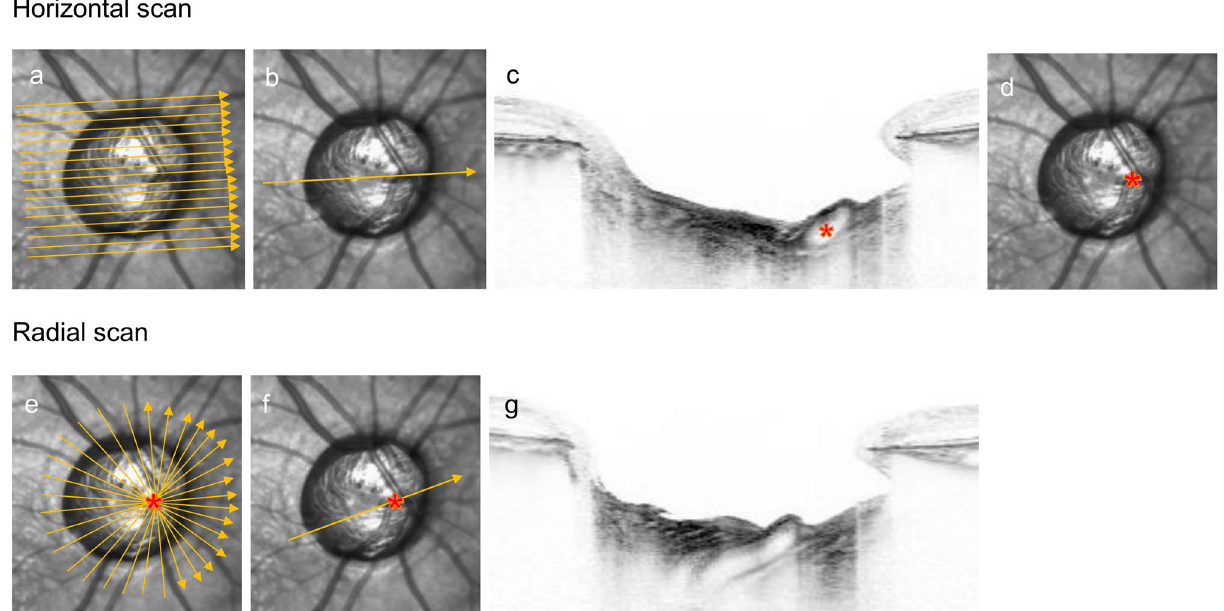
Figure 1. Captured path of the central retinal vessel (CRV) through the lamina cribrosa (LC). ( a ) Horizontal scans of the optic nerve head (ONH) were obtained by alignment to the line that connected the fovea and the disc center (orange arrows). ( b ) Among the horizontal scans, a line that captured the point at which the CRV left the LC to the prelaminar ONH region was identified (orange arrow). ( c ) B-scan image obtained at the scan line shown in ( b ). The red star indicates the point at which the CRV left the LC and emerged on the prelaminar ONH region. ( d ) The point identified in ( c ) was plotted on the corresponding location on the infrared fundus image (red star). ( e ) Radial scans of the ONH were obtained centered on the point at which the CRV left the LC identified in the horizontal scans (red star). ( f ) Among the radial scans, a line that captured the path of the CRV was identified (orange arrow). ( g ) B-scan image that captured the path of the CRV through the LC obtained at the scan line shown in ( f